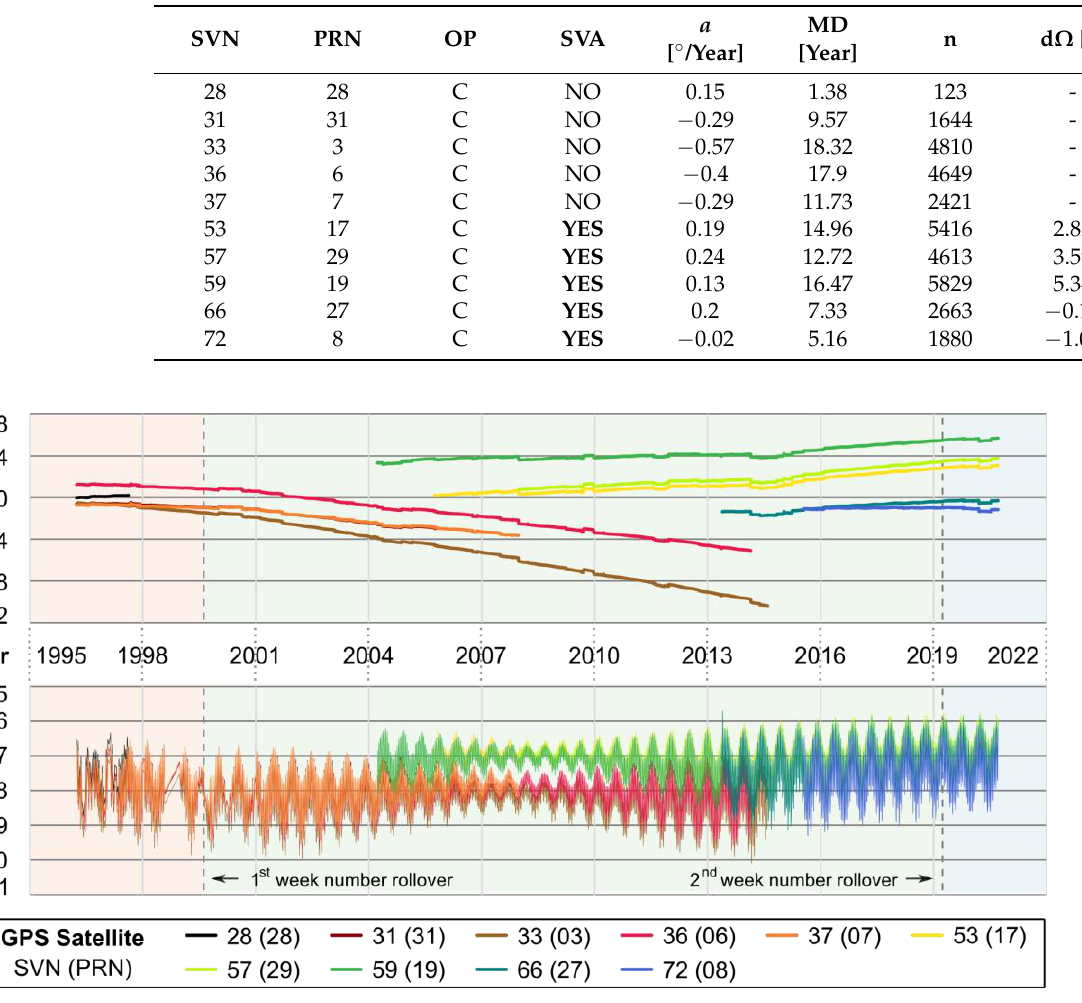
Table A3. Descriptive parameters of the OP C satellites.